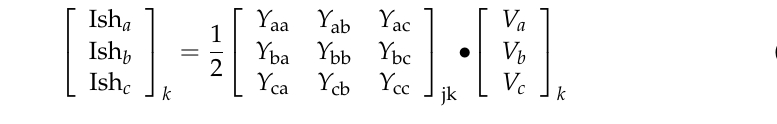
Figure 1. Exact model of three-phase line. Equation (2) gives the phase current matrix for serving the shunt admittance at bus ‘k’.